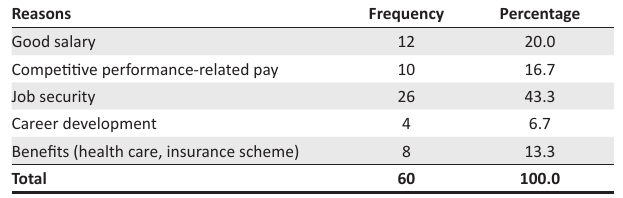
TABLE 2: Reason for still working at Ghana Commercial Bank.